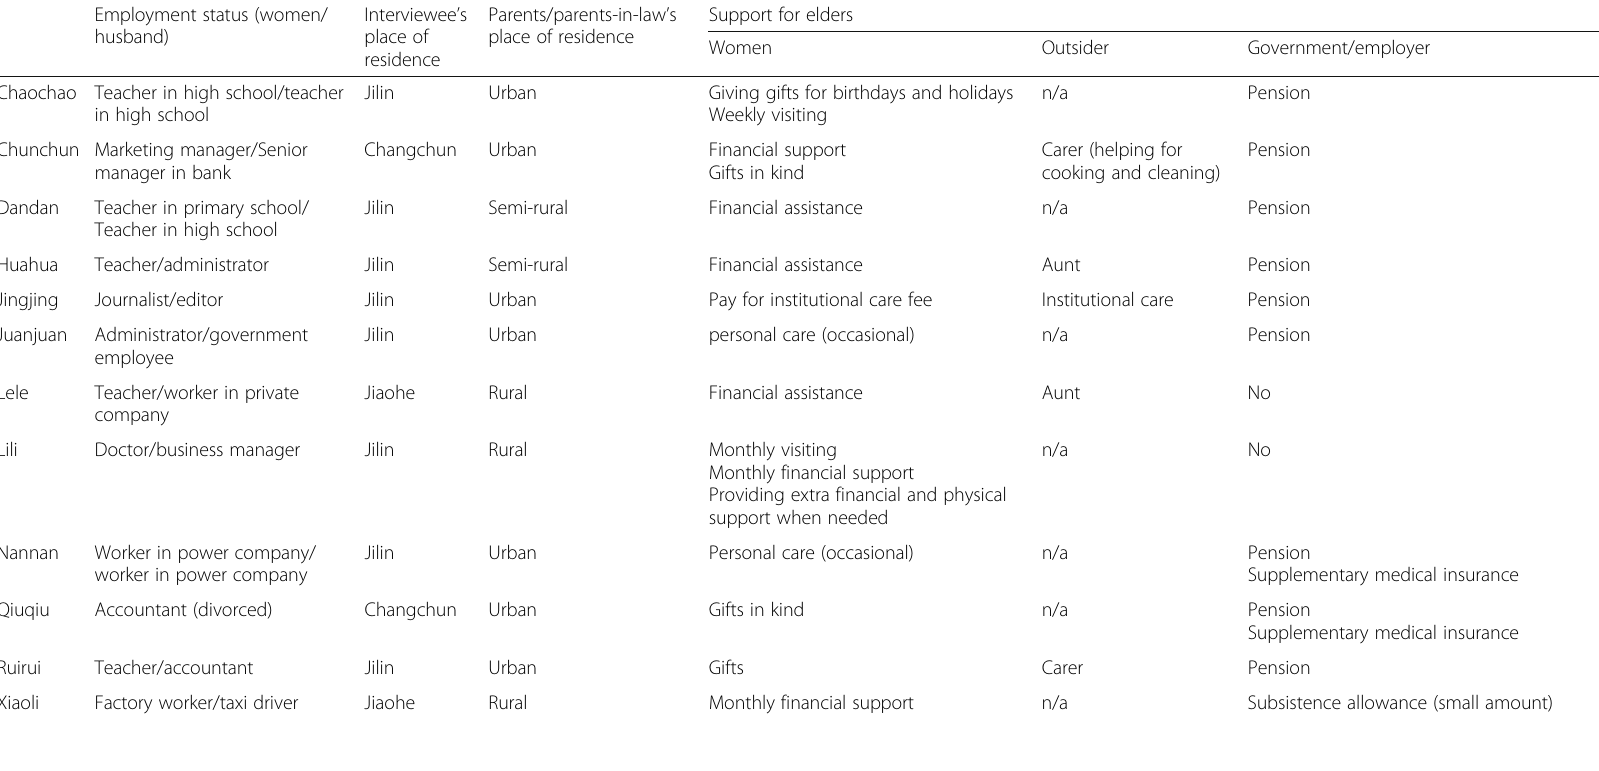
Table 1 Individual circumstances and care for